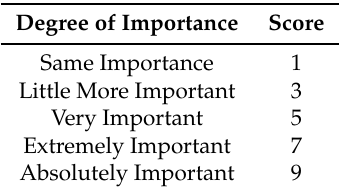
Table 1. Degree of Importance and corresponding